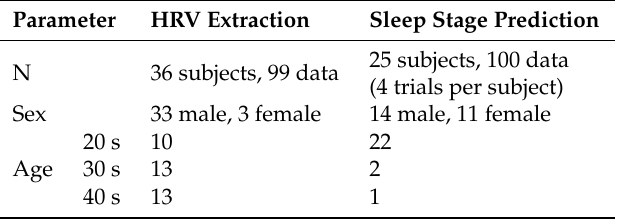
Table 1. Subject demographics for HRV extraction experiment and Sleep stage prediction